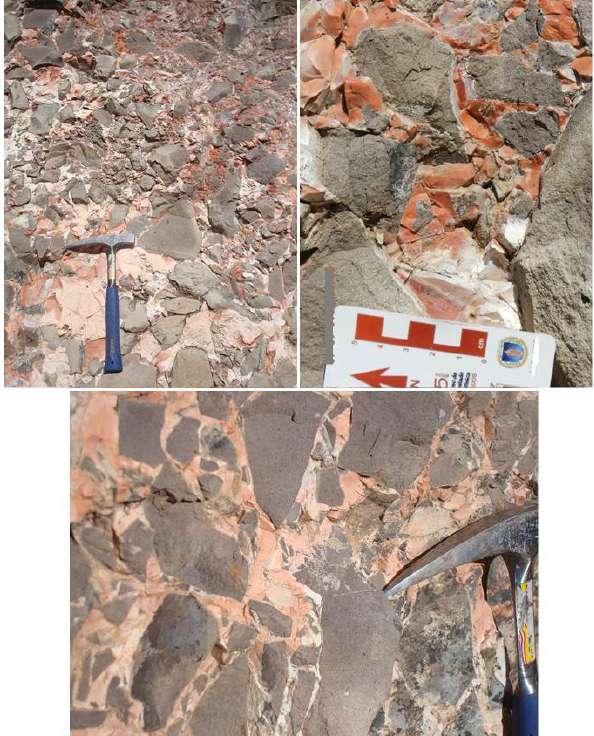
Fig. 7. Blocky peperite formed by interaction of an ATP-type vol- canic body with sediment in the Santa Maria region (Rio Grande do Sul State): well-developed jigsaw-fit texture, closely packed, gray blocky to cuneiform clasts of variable sizes, separated by orange sedimentary material, displaying intense